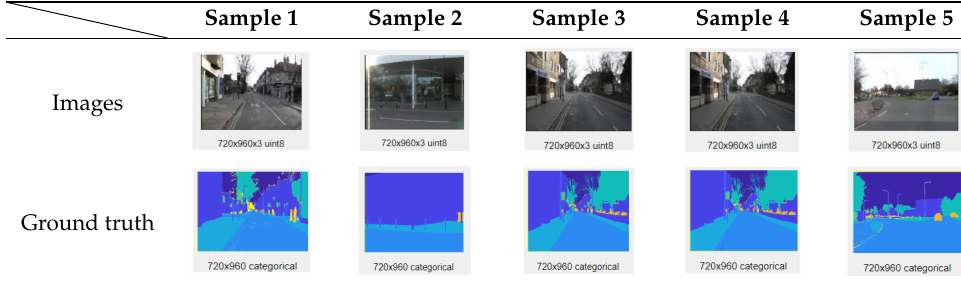
Table 3. Super-pixeled Images and ground truth masks in the CamVid